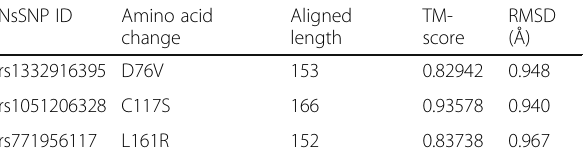
Table 4 TM-align predictions for the most three deleterious